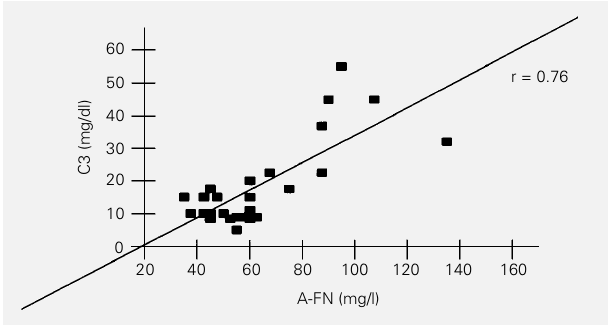
Figure 2 - Correlation between fibronectin (A-FN) and C3 concentrations in the ascitic